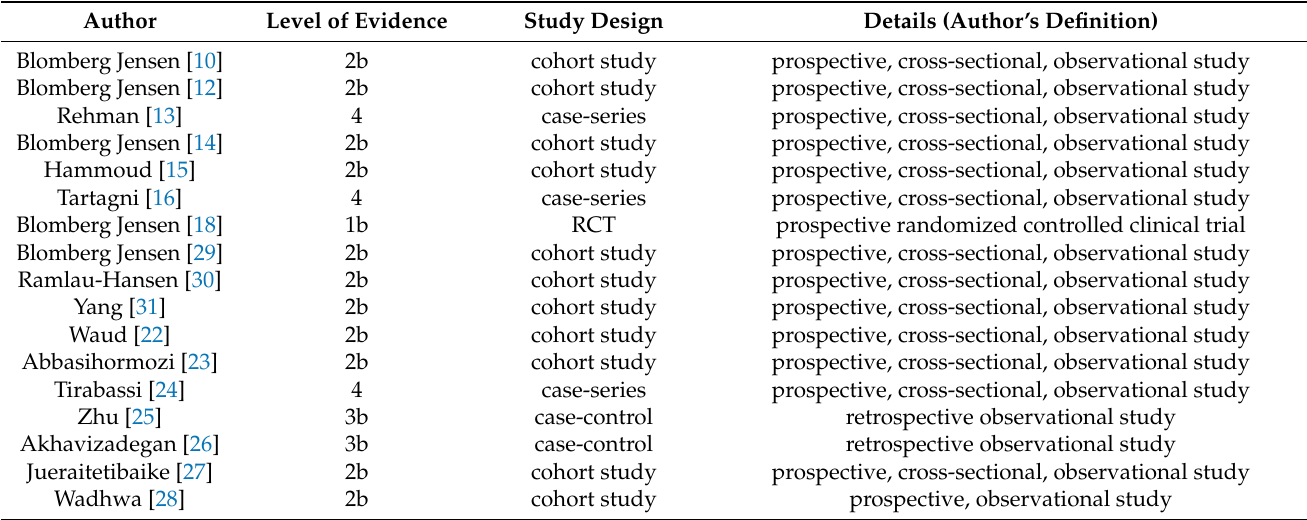
Figure 1. Flow chart of the included studies. Table 1. Levels of evidence of the articles included in the study research.